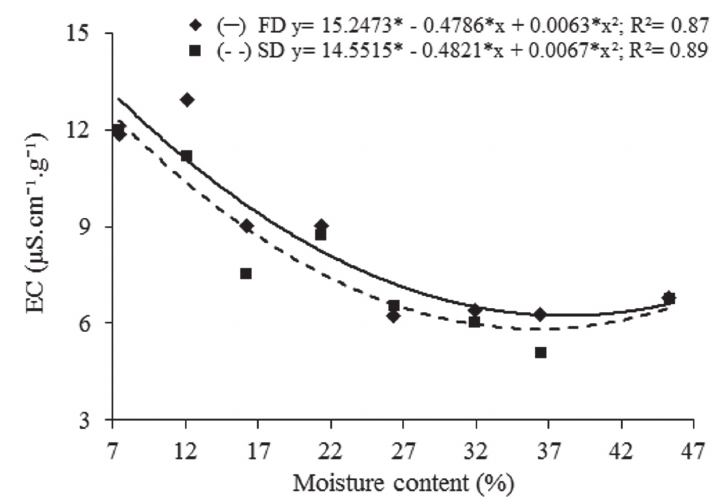
Figure 5 - Effect of drying rate on electrical conductivity (μS.cm -1 g -1 ) of Campomanesia adamantium seeds subjected to fast drying (FD) (silica) and slow drying (SD) (room temperature) at different water contents.